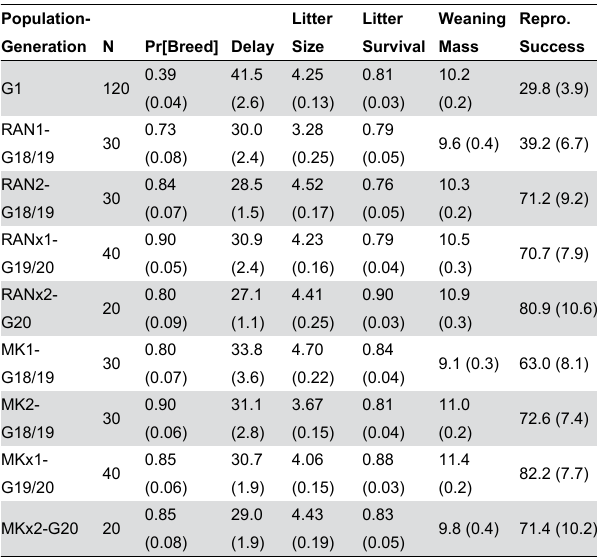
Table 7. Means (SE) of measures of reproductive performance for pairs creating the starting population (G1), final two generations of each experimental population (RAN1, RAN2, MK1, and MK2), and two generations of intercrosses between replicates of each protocol (RANx1, RANx2, MKx1, and